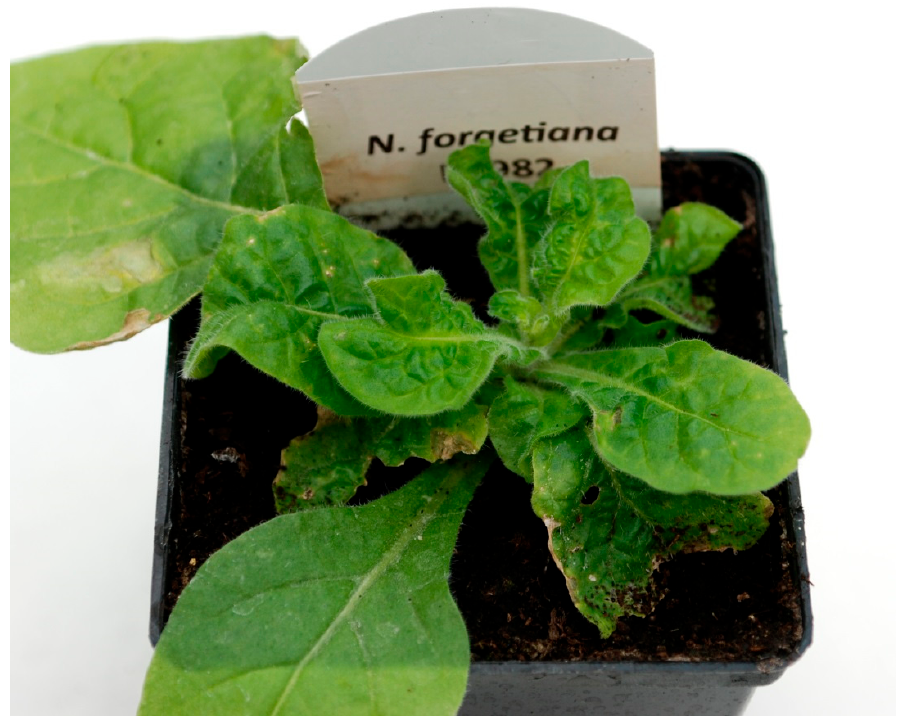
Figure 5. Wrinkled leaves and stunted growth as symptoms of TSWV infection in N. forgetiana species four weeks after inoculation.